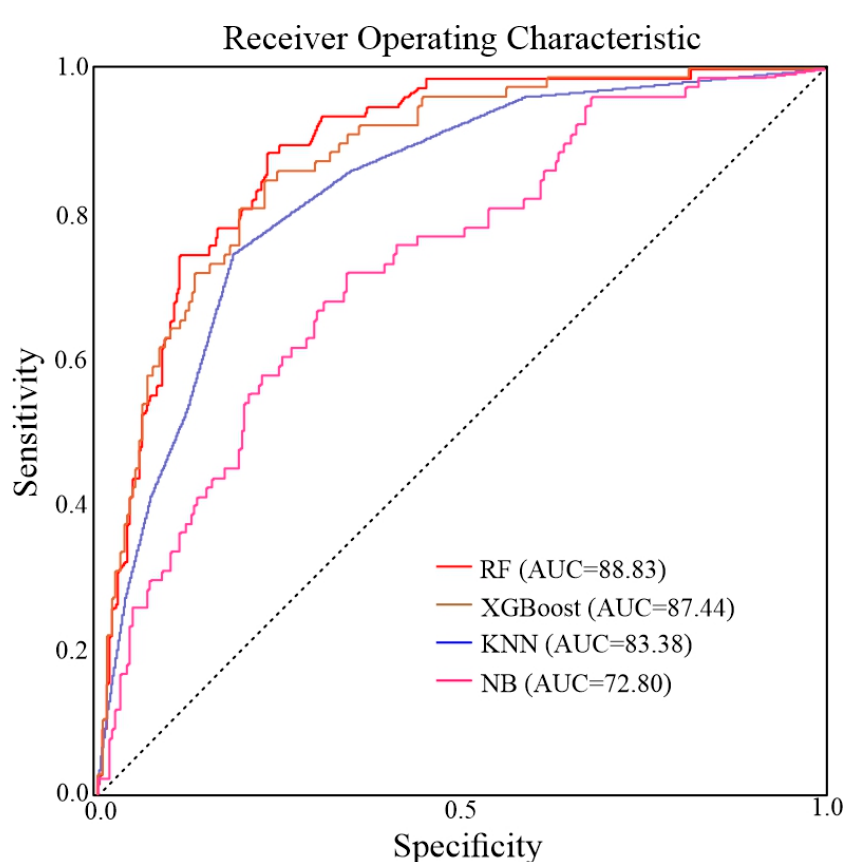
Figure 11 . Receiver operating characteristic plots of models. Figure 11. Receiver operating characteristic plots of Table 5. Confusion matrix of models.